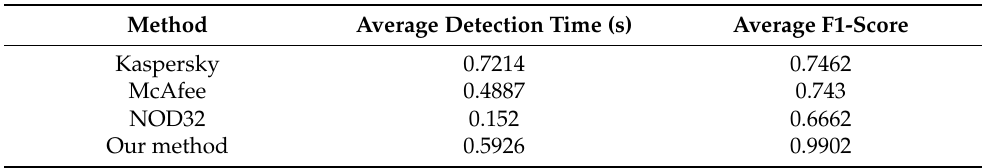
Table 10. The average detection times of different antivirus software.